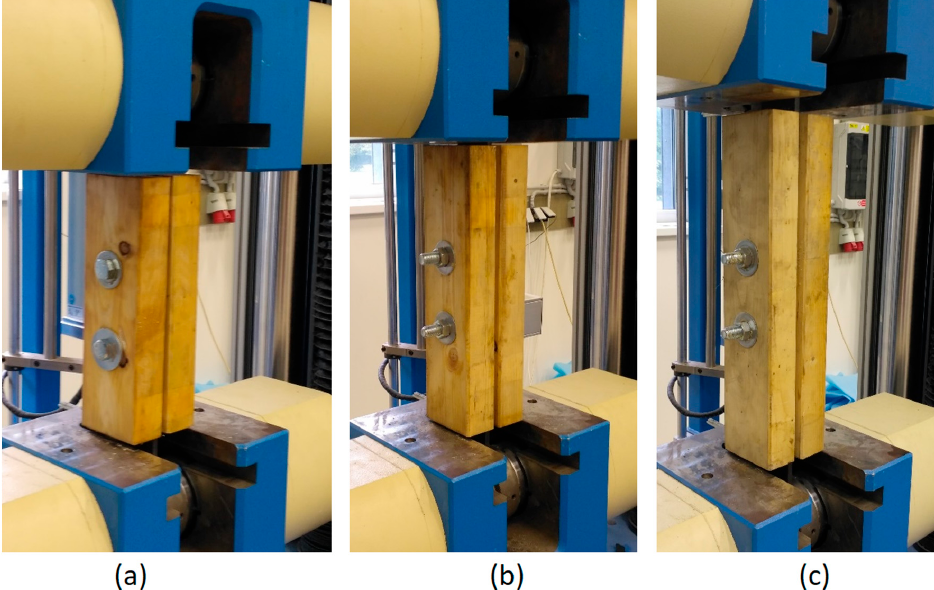
Figure 6. Specimens of squared timber clamped in the jaws of the testing machine: ( a ) H1 specimen– length 400 mm; ( b ) H2 specimen–length 480 mm; ( c ) H3 specimen–length 560 mm.